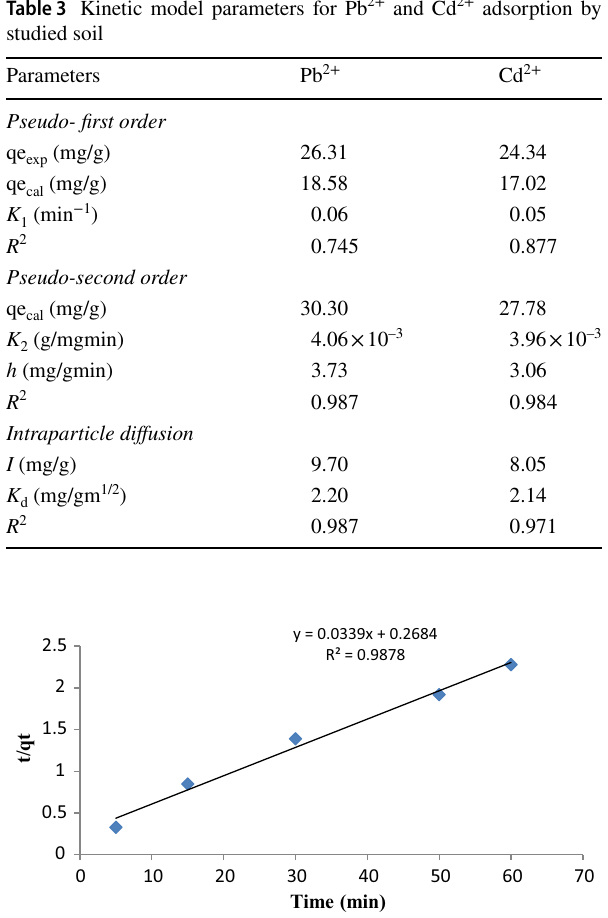
Fig. 5 Langmuir isotherm plot of Pb 2+ adsorption onto Opi soil Fig. 7 Pseudo-second-order plot of Pb 2+ adsorption onto Opi y = 0.0414x + 0.079 R² = 0.9719